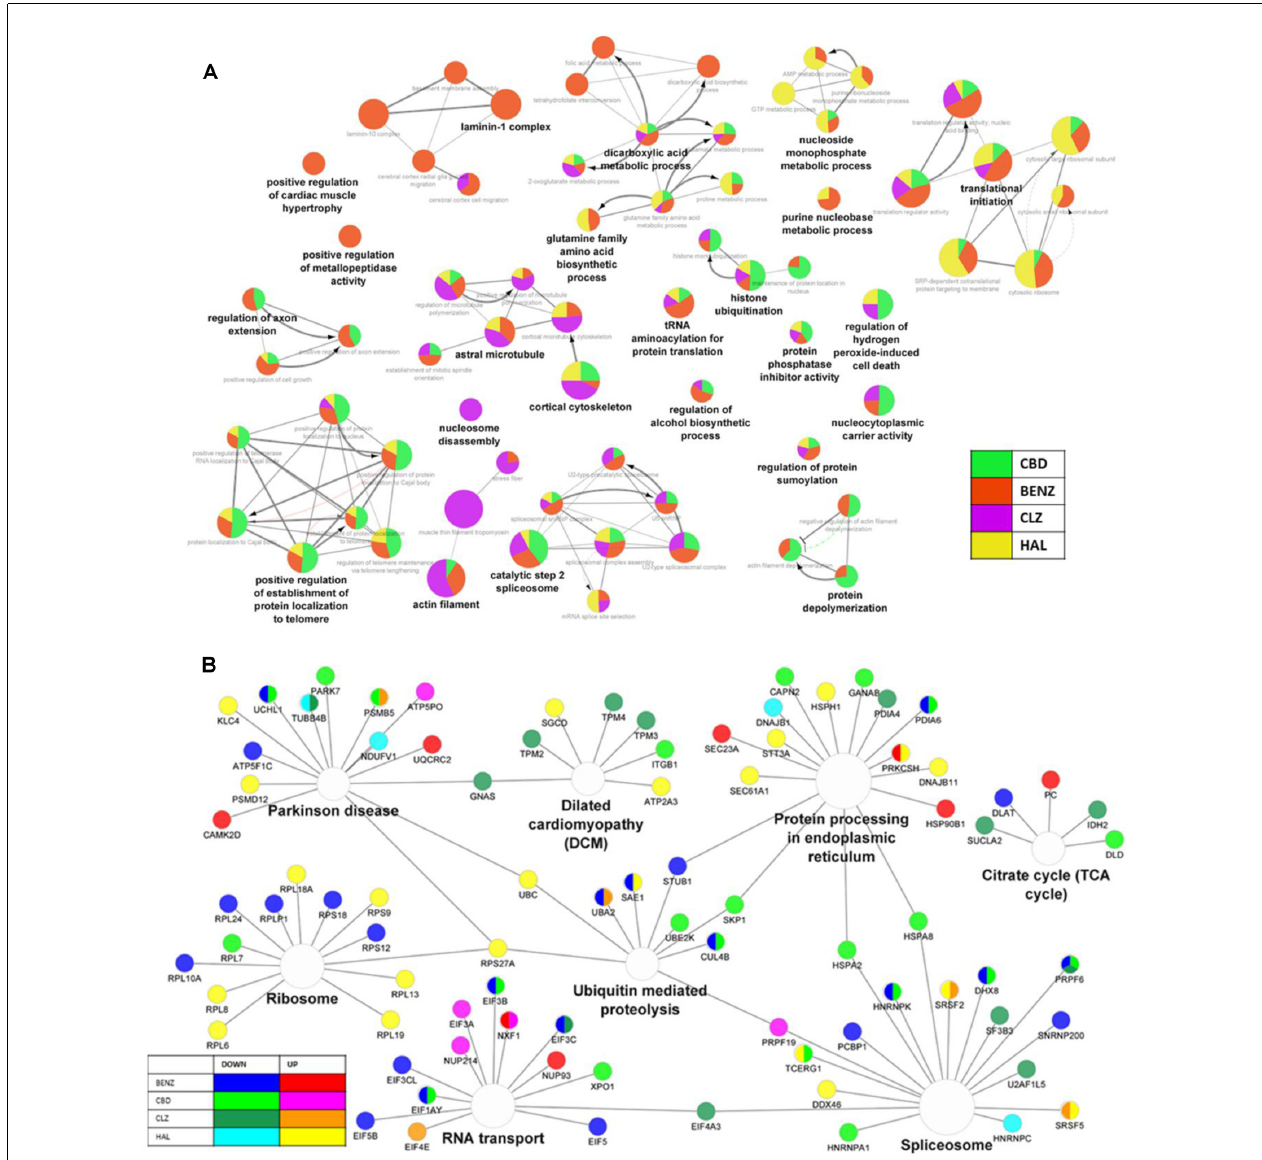
FIGURE 4 | (A) The network of gene ontology terms, affected by cannabidiol, benztropine, clozapine, and haloperidol co-treatments compared to cuprizone, according to proteomic analysis, showing the percentage of visible genes of a term or pathway. (B) Network of pathways affected by cannabidiol, benztropine, clozapine, and haloperidol co-treatments, according to proteomic analysis, showing the hub genes shared between the enriched KEGG pathways. The gene ontology interaction network was obtained by functional enrichment analysis using the ClueGO plug-in in Cytoscape. All terms were selected by significance ( p < 0.05) following a Benjamini–Hochberg